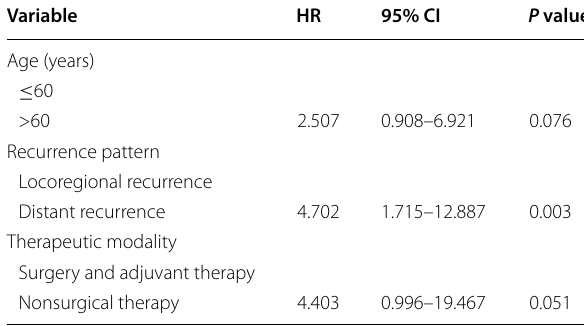
Table 4 Multivariate Cox regression analysis of post-recur- rence survival of 52 patients with recurrent